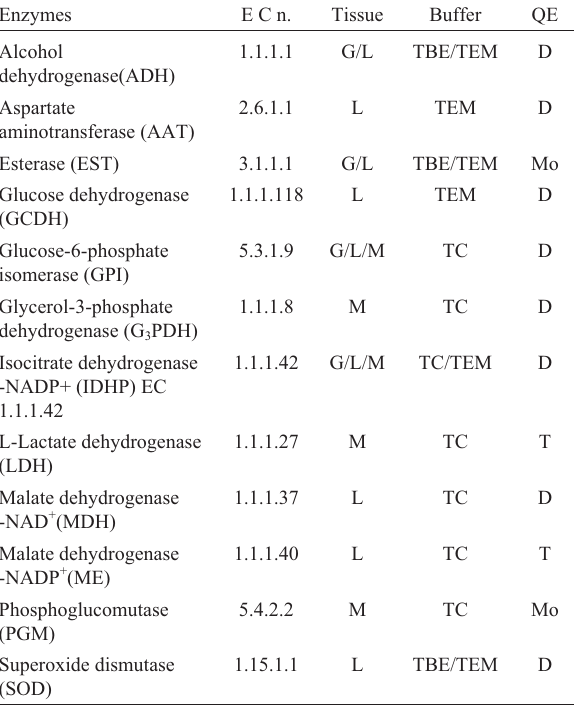
EC n. = Enzyme Commission number; G = gill; H = heart; L = liver; M=muscle;TEM=Tris/EDTA/MaleatepH7.4(ShawandPrasad,1970); TBE = Tris/EDTA/borate pH 8.6 (Boyer et al. , 1963); III TC = Tris/citrate pH 7.0 (Shaw and Prasad, 1970); D = dimeric; Mo = monomeric; T =